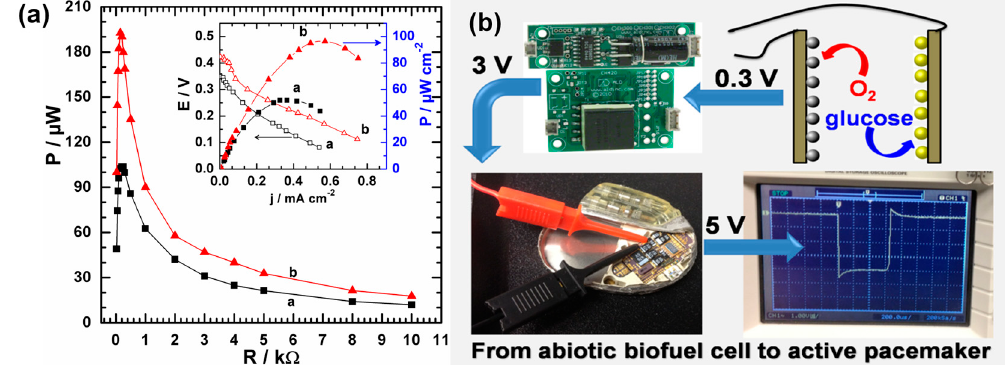
Figure 13. ( a ) Polarization characteristics of the fuel cell composed of the Au/CB ‐ modified buckypaper anode and the Au 60 Pt 40 /C ‐ modified carbon paper cathode operating in human serum solution (pH 7.75, room temperature) containing 5.4 mM (i) and 20 mM (ii) glucose: The main panel shows the power released on the external variable resistance ( R ), the inset shows the cell voltage and the released power as functions of the current density; ( b ) The scheme of the experimental setup including: a flow FC, an energy ‐ harvesting circuit, a pacemaker, and an oscilloscope for registration of the pacemaker output signals. Reprinted and adapted with permission from Reference [181]. Copyright Wiley ‐ VCH Verlag GmbH & Co. KGaA, 2014.